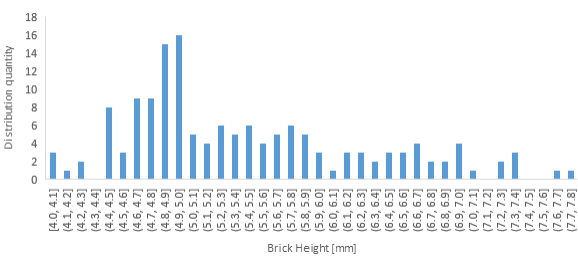
Figure 14. Histogram of the thicknesses in the area